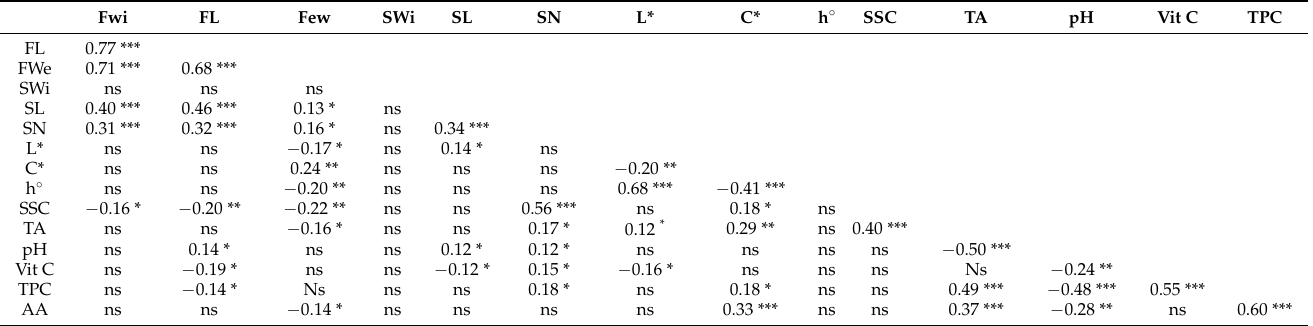
Table 4. Correlation coefficients among the investigated characteristics.